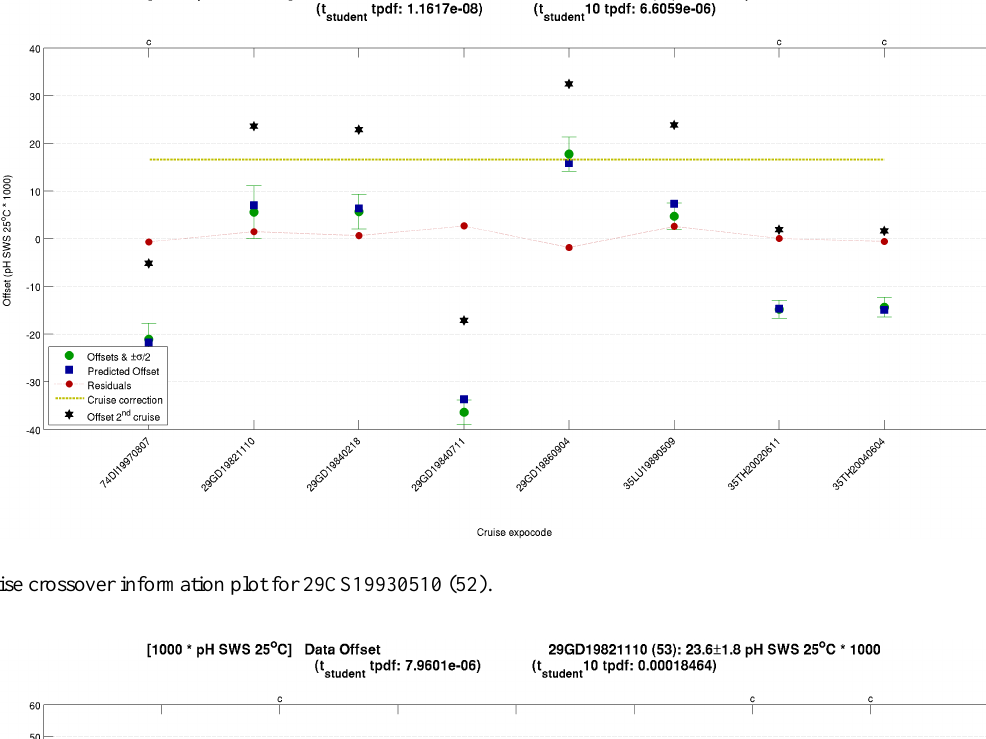
Figure 8. Cruise crossover information plot for 29CS19930510 (52).